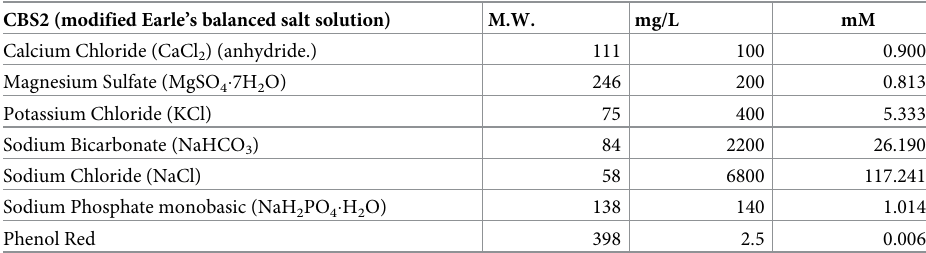
Table 1. Components of